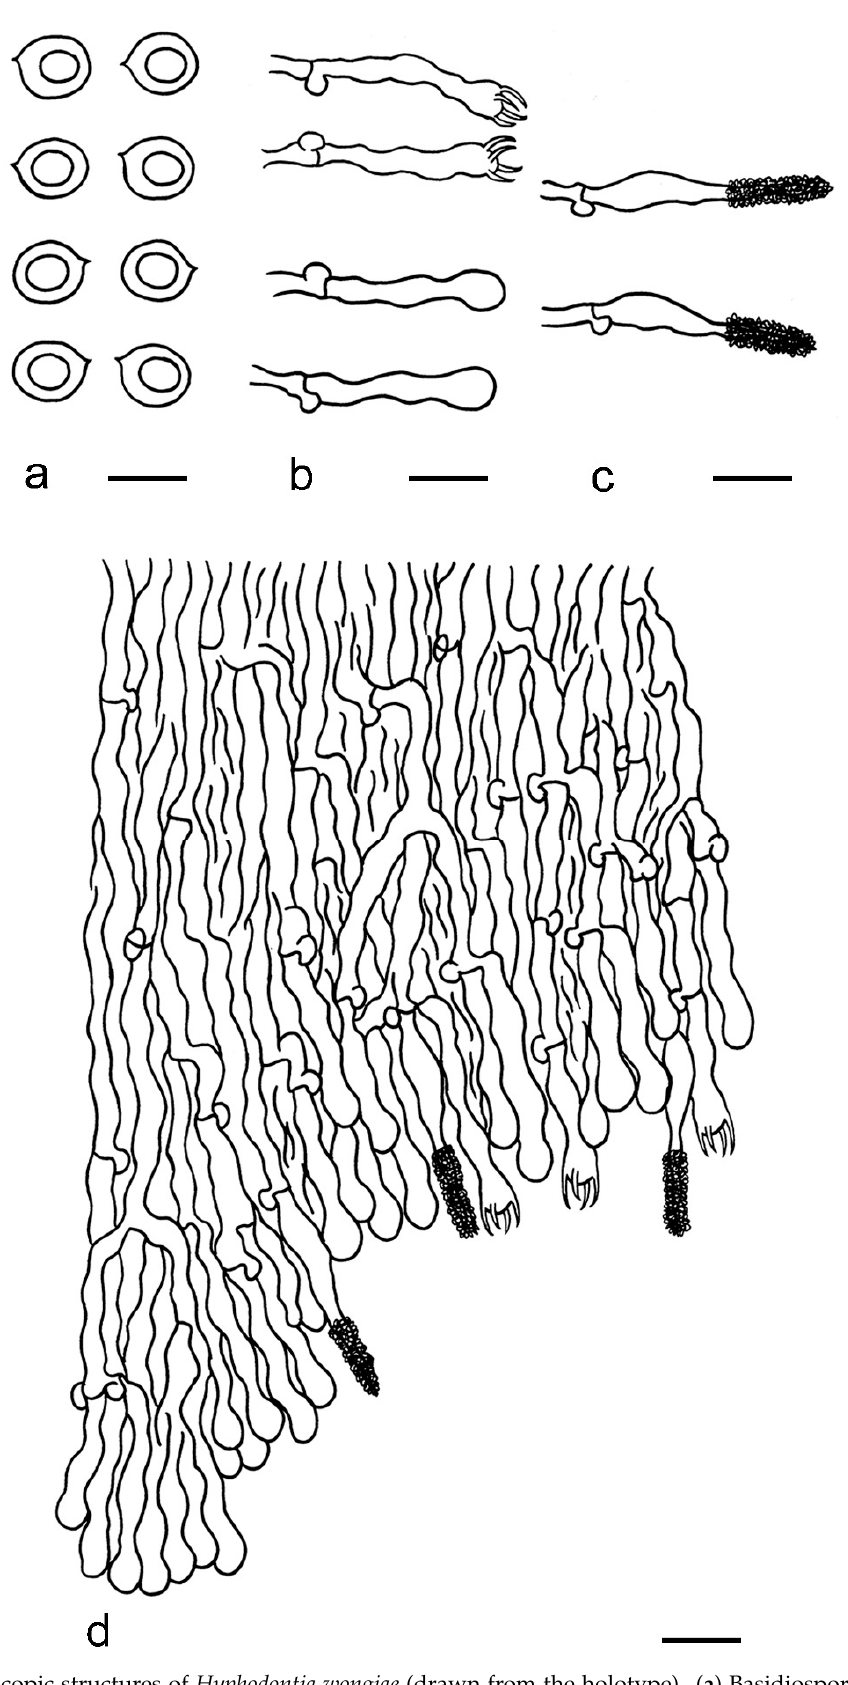
Figure 13. Microscopic structures of Hyphodontia wongiae (drawn from the holotype). ( a ) Basidiospores; ( b ) basidioles; ( c ) lagenocystidia; ( d ) a section of the basidiocarp.—Scale bars: a = 5 μ m; b–d = 10 μ m.